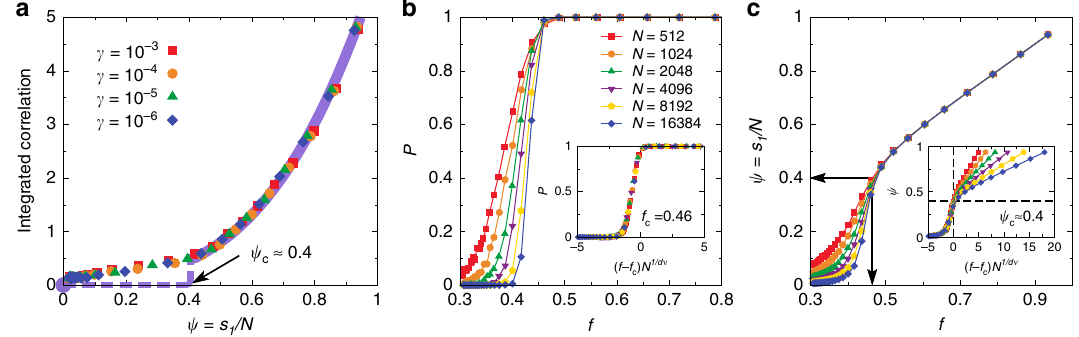
Fig. 4 Percolation of force-bearing particles gives rise to long-range stress correlation. a Corresponding to Fig. 1c, the integrated shear-stress correlations for different cooling rates γ are plotted as a function of the relative size of the largest force-bearing network ψ = s 1 / N , with N = 4096. The nice collapse of the data at different γ suggests that the shear-stress correlation, more speci fi cally, its far- fi eld behaviour, is uniquely controlled by the largest force-bearing network. Note that many high-temperature data points of liquids have rather low but fi nite values of both the integrated correlation and ψ , and the nonequilibrium glass transition is signalled by the rapid growth of both of them. However, the fi nite-size scaling of ψ (see b and c ) reveals that the non-zero values of both the integrated shear-stress correlation and ψ below the percolation threshold (left-lower side) actually originate from fi nite-size effects. Therefore, in the large system-size limit, the fi lled circle at the origin should describe all liquid states. Then, the dashed line indicates the abrupt emergence of percolated force-bearing network and long-range stress correlations across the nonequilibrium glass transition, and the solid line illustrates the general relation between them for a further decrease of temperature. b Percolation probability P as a function of the fraction of force-bearing particles f for different system-sizes N at γ = 10 − 4 . Inset: Scaling collapse of P from different system sizes. Here d = 2 is the spatial dimension, ν = 4/3 is the scaling exponent, and f c = 0.46 is the critical occupation fraction. c Corresponding to ( b ), the relative size of the largest cluster ψ = s 1 / N as a function of f for different system sizes. The vertical and horizontal arrows indicate f c = 0.46 and the corresponding ψ c , respectively. Inset: Scaling collapse of ψ from different system sizes below the percolation transition, using the same f c and ν as the inset of ( b ). The horizontal dashed line indicates ψ c ≈ 0.4 at the percolation threshold f c . Taken together, both ( b ) and ( c ) indicate that, when N → ∞ , an abrupt formation of system-spanning force-bearing network takes place across the nonequilibrium glass